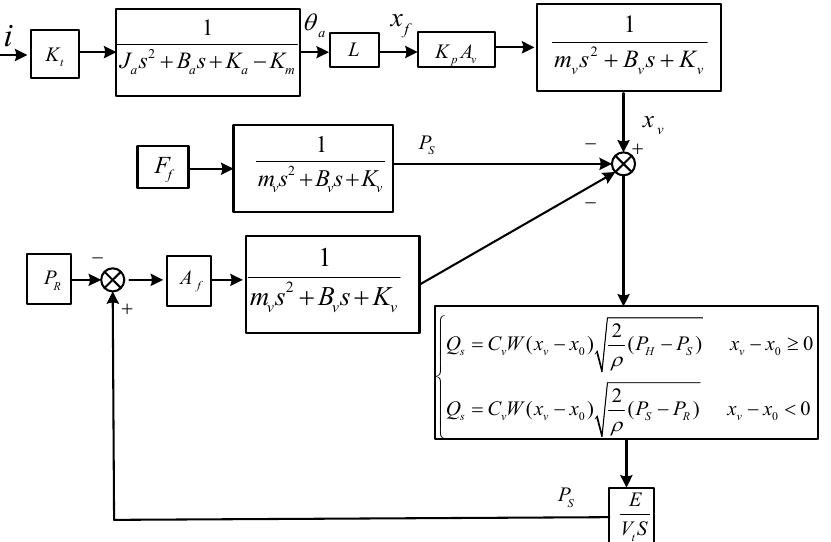
Figure 4. The dynamic transfer block diagram of the DJSV.